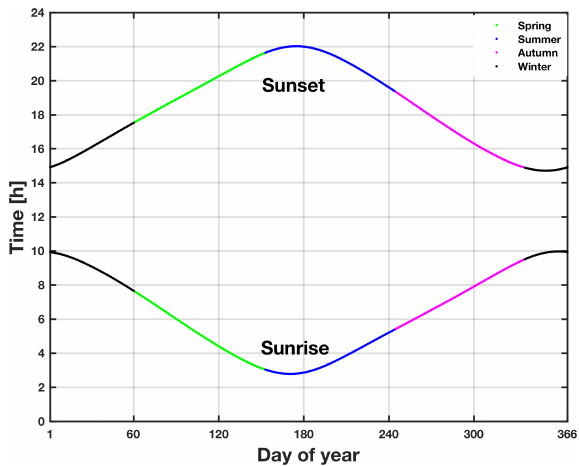
Figure 3. Estimated sunrise and sunset time of different seasons for Hyytiälä SMEAR II station (61 ◦ 51 (cid:48) N, 24 ◦ 17 (cid:48) E,